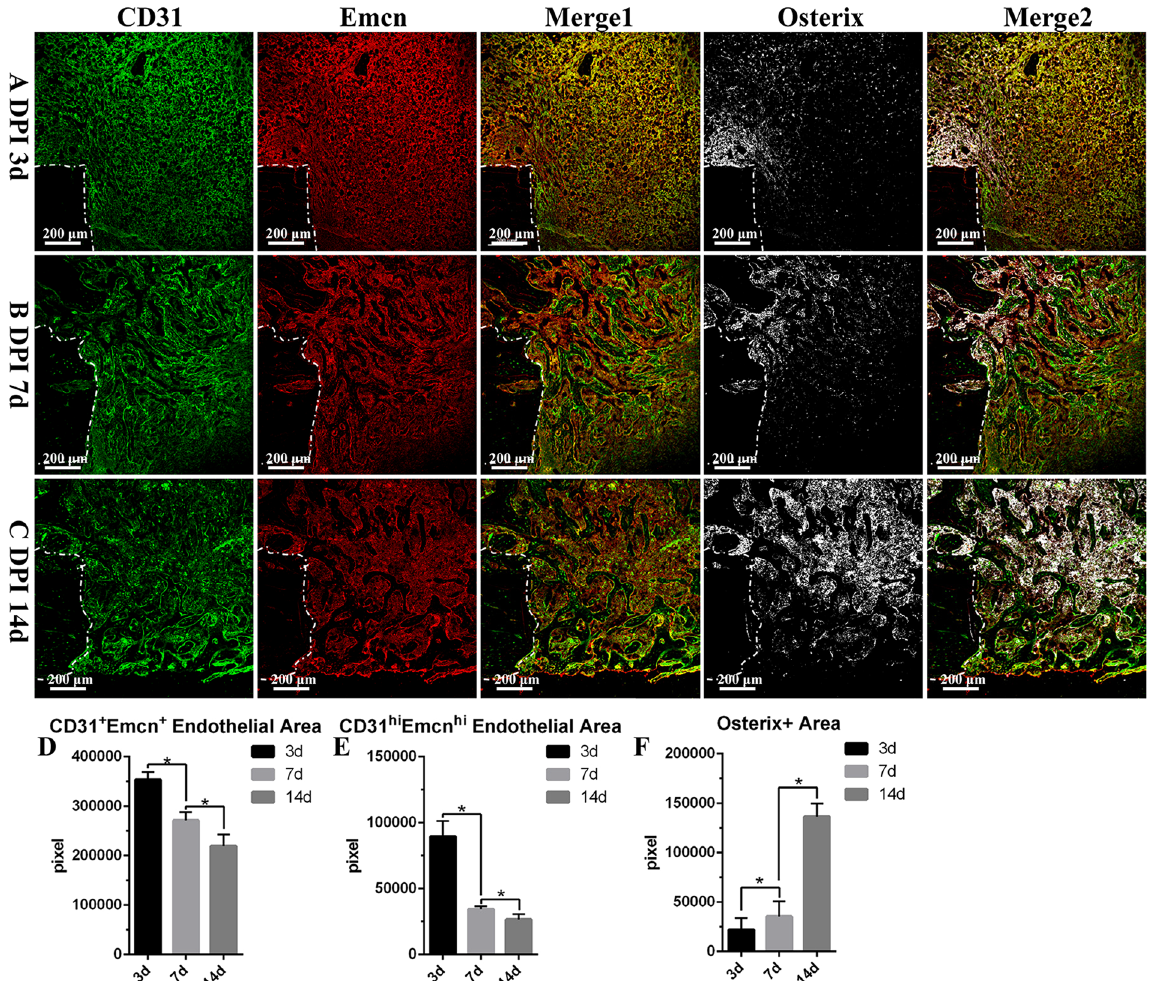
Figure 4. The proliferation and distribution of CD31hiEmcnhi vessels and osterix + cells at different time points during the bone defect repair process in normal rats. ( A ) High levels of CD31hiEmcnhi vessels were distributed across the whole repair area at 3 days post-injury. A large number of osterix + cells were concentrated near endosteum at the damaged edge. ( B ) Vessels could be identified both at the surface and the periphery of trabecular bones at 7 days post-injury. Relatively high levels of CD31hiEmcnhi vessels were distributed at the surface of the growing trabecular bones near the frontier growth area. Most osterix + cells were distributed at the surface of trabecular bones and some were attached on vessels. ( C ) High levels of CD31hiEmcnhi vessels were distributed at the surface of the growing trabecular bones near the lateral margin of cortical bone at 14 days post-injury. While at the surface of trabecular bones inside the cavity distributed very low level of CD31hiEmcnhi vessels. ( D–F ) Statistical comparisons of CD31 + Emcn + endothelial area, CD31hiEmcnhi endothelial area and osterix + area at 3, 7 and 14 days post-injury. * P < 0.05, n = The decreased bone mass in the process of bone defect repair under osteoporotic condi- tions was related with the reduction of CD31hiEmcnhi vessels and low transcriptional levels of Hif-1 α , VEGFA, BMP2 and osterix. Micro-computed tomography (CT) analyses revealed that the bone volume fraction (bone volume/total volume, BV/TV), trabecular thickness (Tb.Th.) and trabecular number (Tb.N.) decreased significantly at 7 and 14 days post-injury in OVX rats, whereas the bone surface-to-volume ratio (bone surface/total volume, BS/TV) and trabecular spacing (Tb.Sp.) significantly increased (Fig. 5A–I). These changes demonstrated that the osteogenesis after bone defect in OVX rats was significantly insufficient relative to that in normal rats. H/E staining revealed that the degree of hematoma organization was significantly reduced at 3 days post-injury under osteoporotic conditions. A large number of proliferating cells accumulated at the edge of the defect. While only a small number of cells migrated into the inner portion of the repairing tissue. These results may be attributed to the lack of neovascularization (Fig. 5J). The number and thickness of newly formed trabecular bones decreased in OVX rats at 7 days post-injury, consistent with the results of micro-CT scanning. The trabecular structure was disordered compared with that in normal rats (Fig. 5K). Similarly, the number and thickness of trabecular bones at 14 days post-injury in OVX rats reduced significantly, while the space increased significantly. The entire trabecular structure was loose and porous in OVX rats compared with